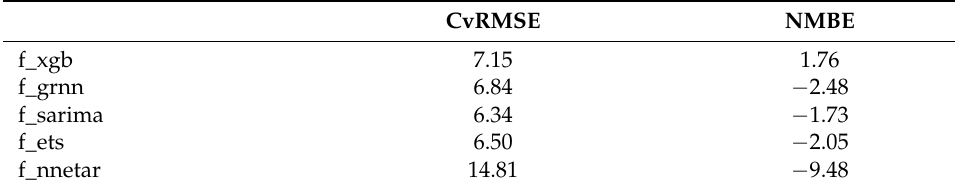
Table A5. Monthly forecast error measure (in %).